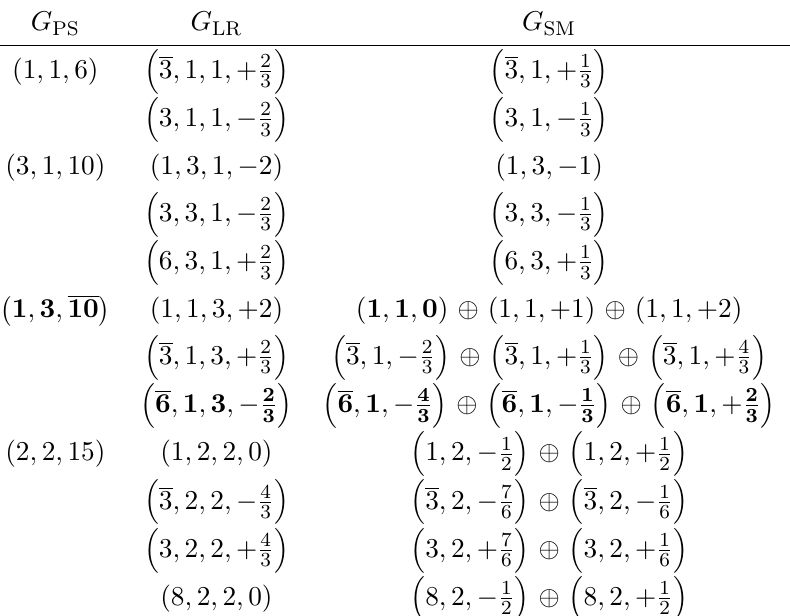
Table 10 . Decomposition for the representation 126 of SO(10) under G PS , G LR and G SM . We highlight the representations relevant to the discussion in the main text in bold.